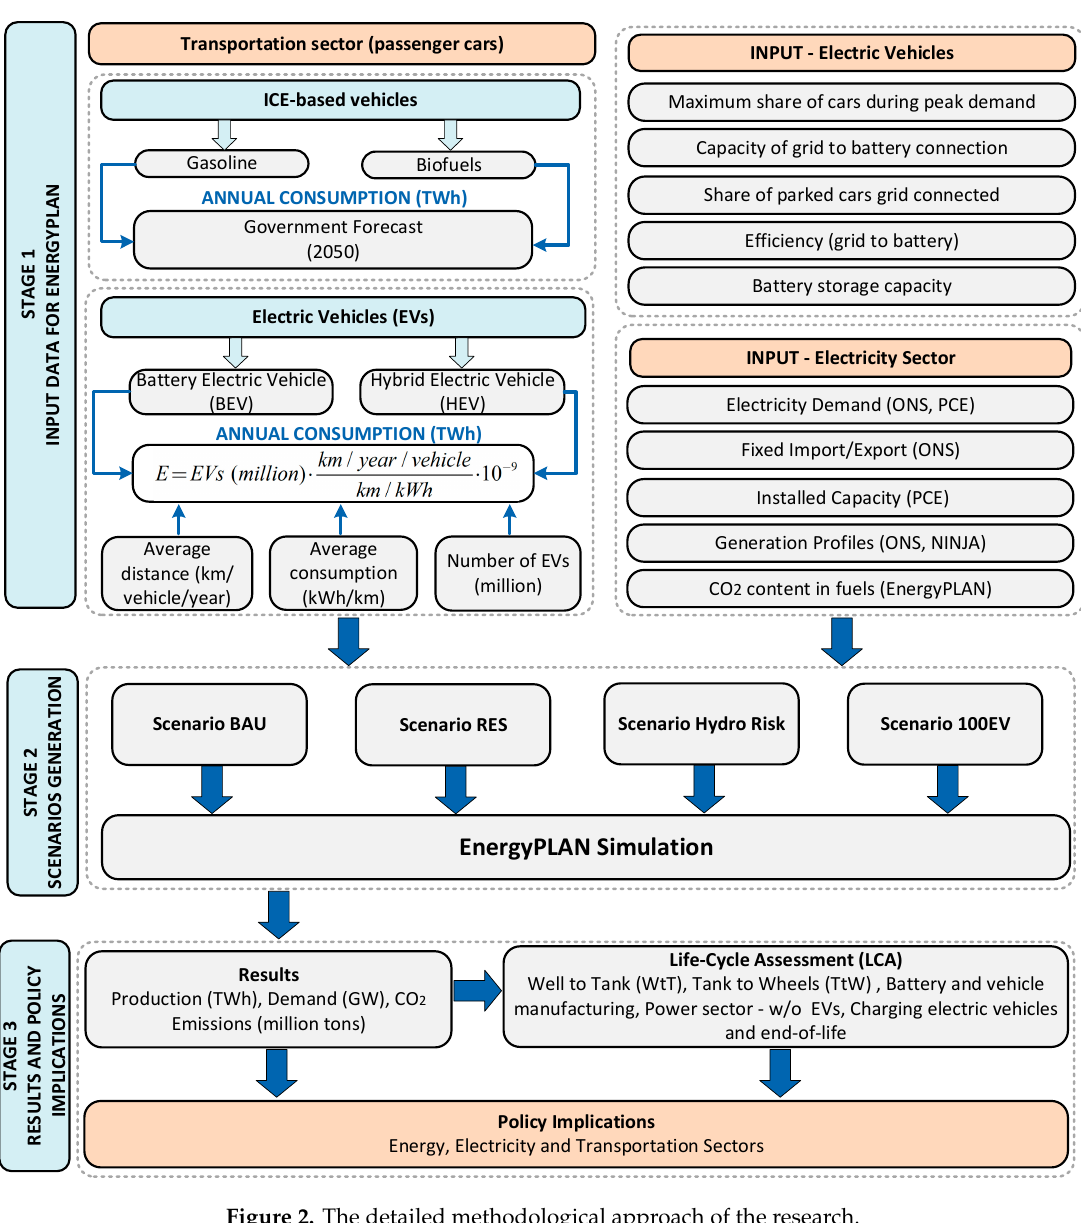
Figure 2. The detailed methodological approach of the research.